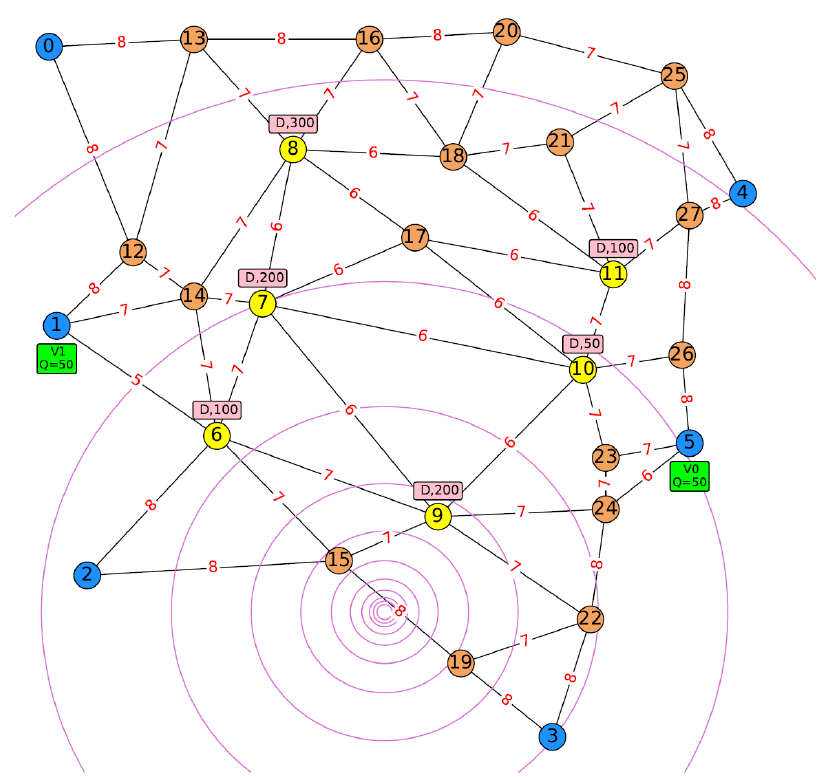
Figure A4. Road network for instance D6N16S6.